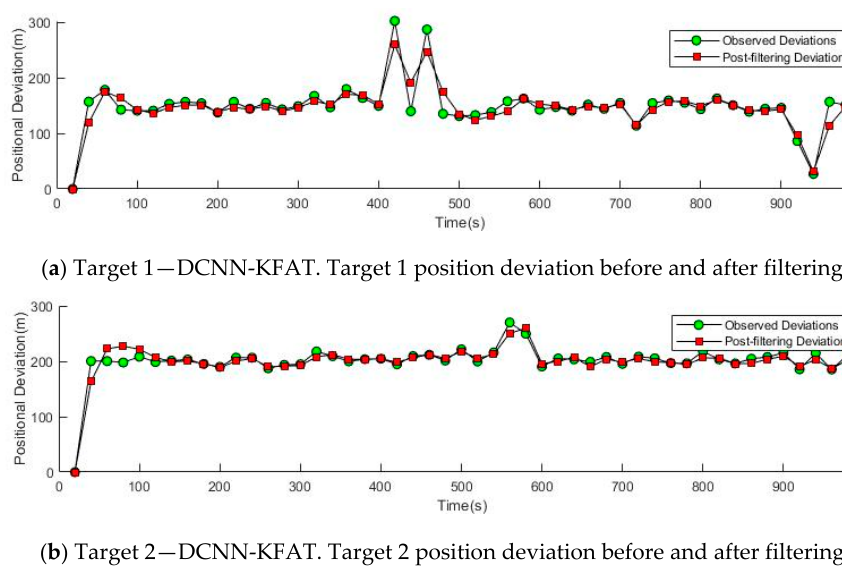
Figure 17. Using the DCNN-KFAT method, the deviation is around 200 m.